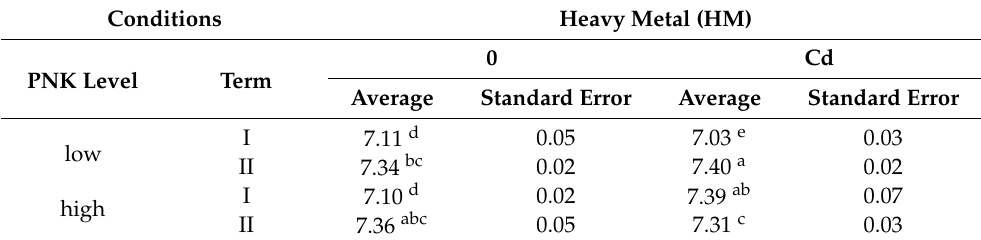
Table 8. The reaction (pH) of water in the three tested growing seasons.